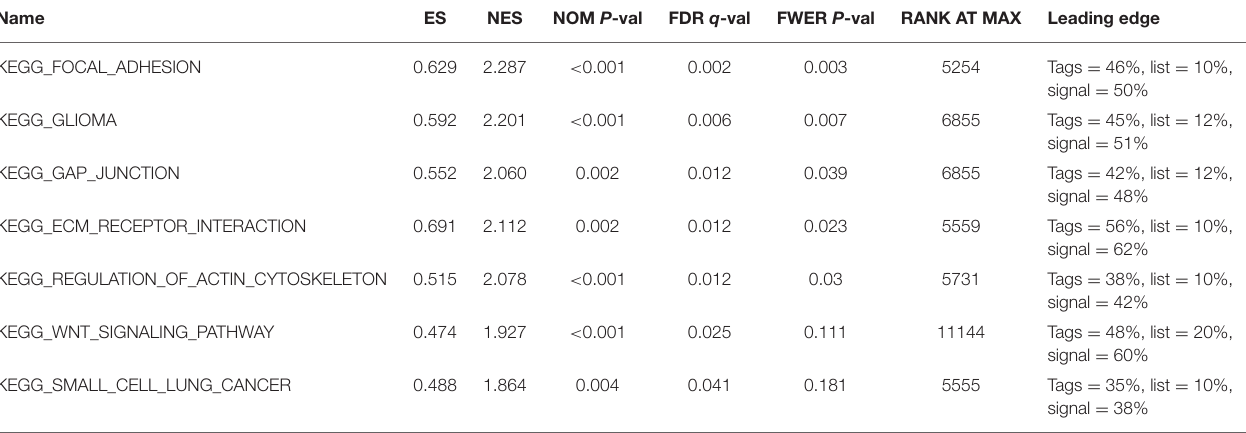
TABLE 5 | Gene set enrichment analysis (GSEA) results based on 15 autophagy lncRNA